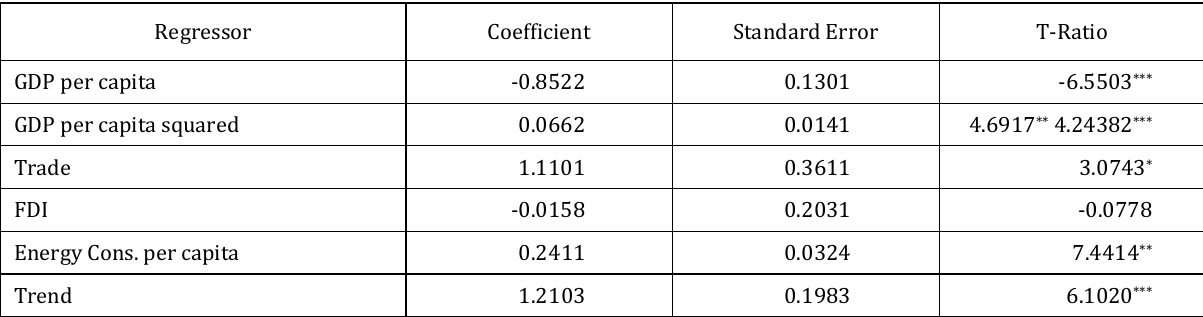
Table 3. Estimated long run coefficients (source: author’s